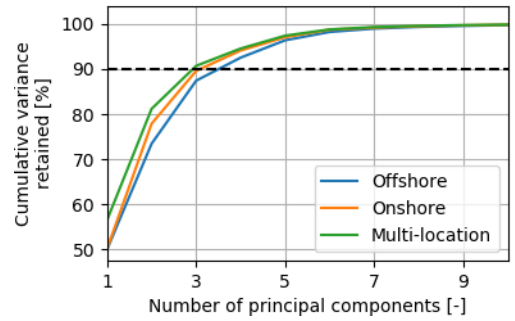
Figure 3. Relationship between the percentage of variance retained and the number of PCs for the filtered offshore, onshore, and multi- location datasets analysed in Sect. 4.1, 4.3, and 4.4,